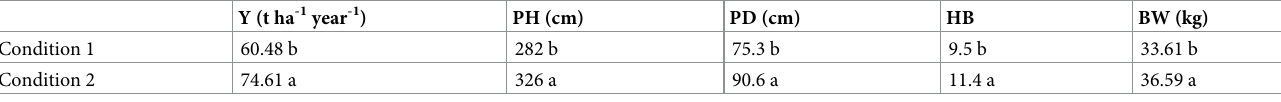
Table 3. Yield and agronomic variables evaluated in this study.